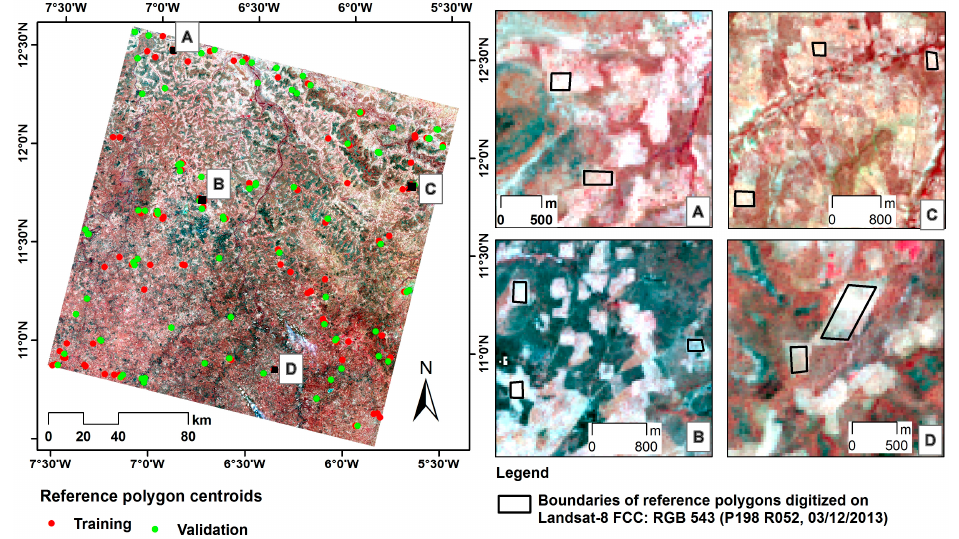
Figure 2. ( Left ) Spatial distribution of reference polygons (represented by their centroids) on the Landsat scene P198_R052; and ( Right ) detailed views of reference polygons digitized around croplands, where ( A – D ) correspond with the labels A–D on the Landsat scene on the left.